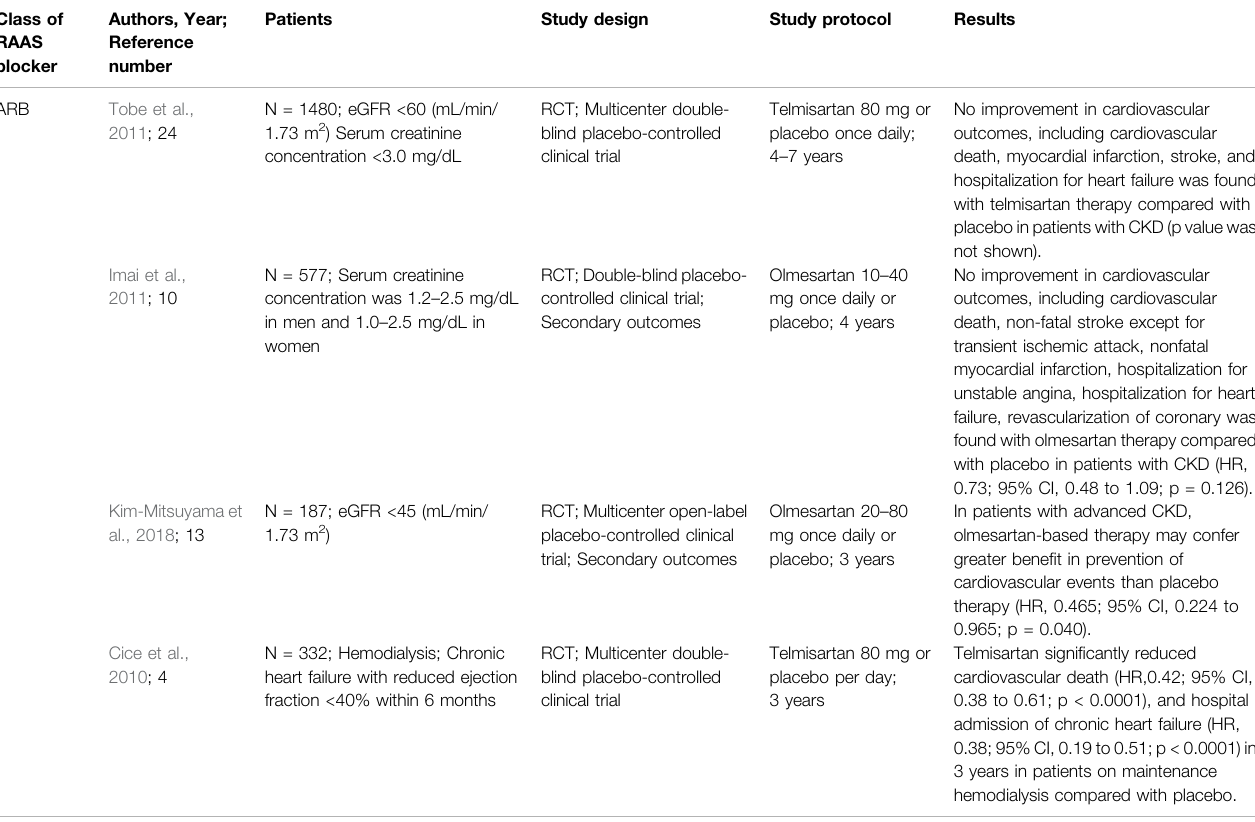
TABLE 1 | Effects of angiotensin receptor blockers on the development of cardiovascular disease in pre-dialysis or on-dialysis patients with CKD. Class of RAAS